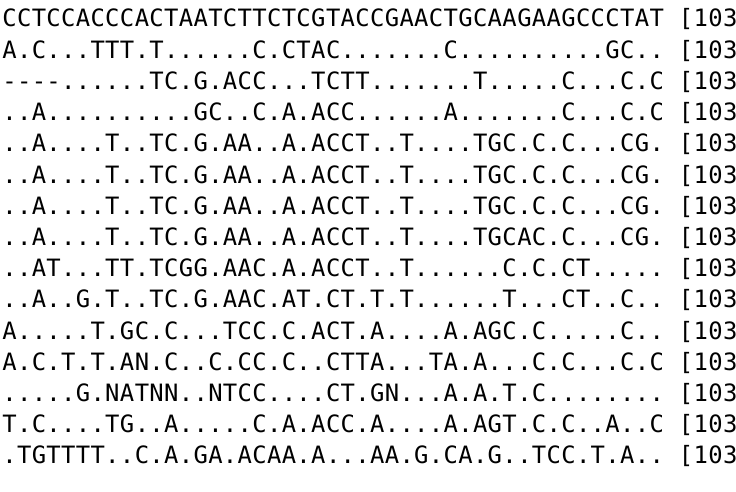
Figure 2. Haplogram of COI gene showing the variable sites among the 15 samples (12 species) representing different families of the orders Gruiformes, Ciconiiformes, Podicipediformes and Crocodylia (out group). The identical sites are represented by